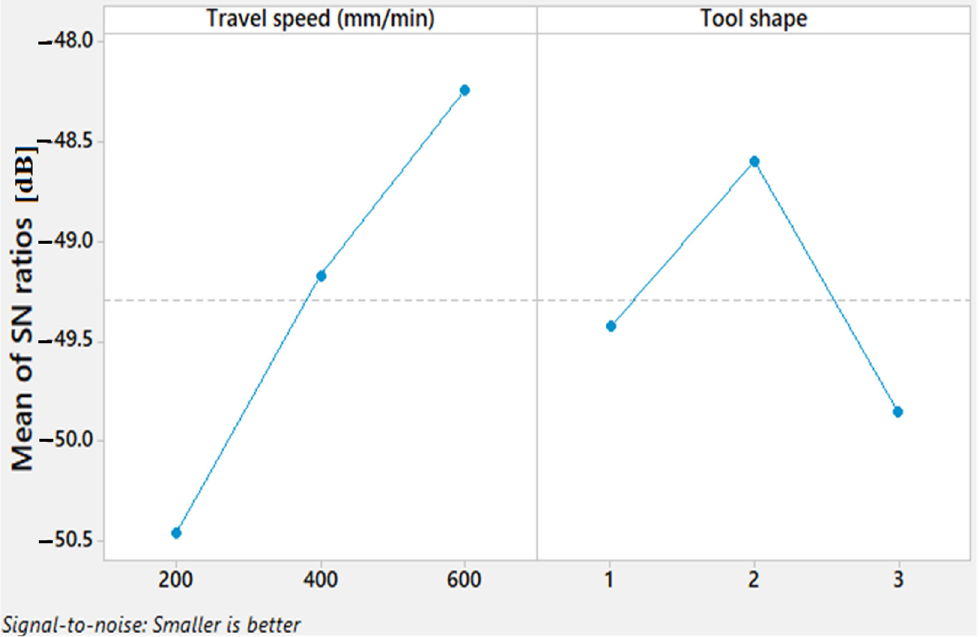
Figure 7. Mean S/N ratio for Tw. Figure 8 represents the contour plot for Tw as a function of travel speed and tool